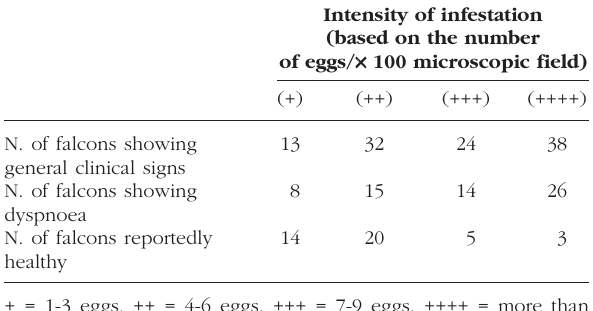
Table II. – Relationship between intensity of infestation and presence of clinical signs in 149 falcons from Kuwait infested with Serrato- spiculum seurati .